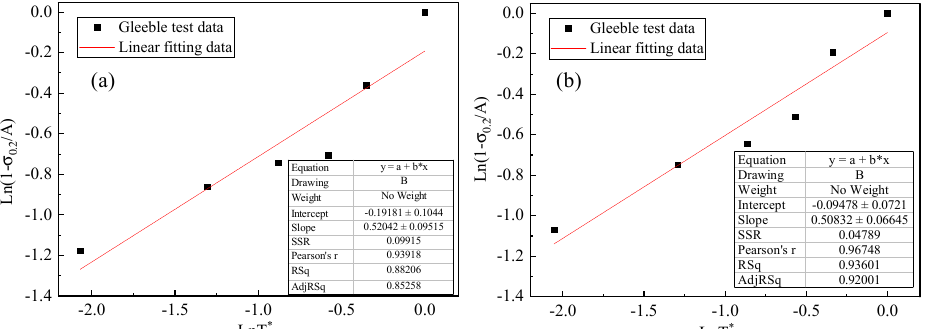
Figure 4. Parameter fitting of m and p of 316L and Q235B material constitutive models. ( a ) 316L; ( b )